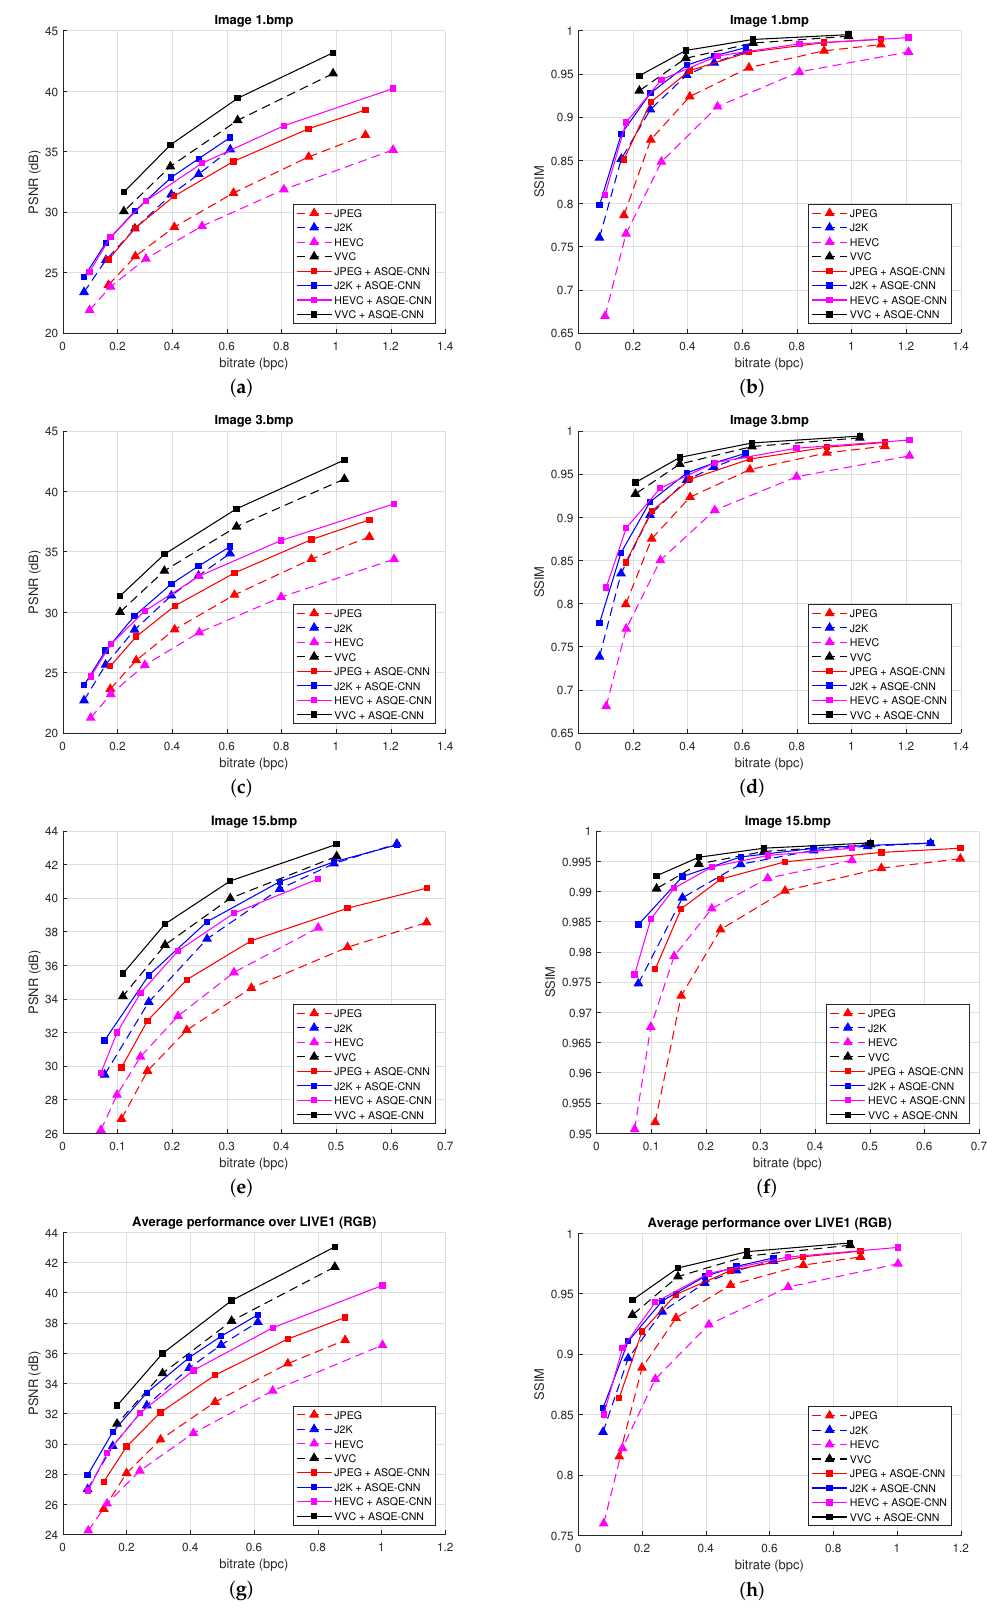
Figure 6. Rate-distortion results for three images, ( a , b ) Image 1.bmp , ( c , d ) Image 3.bmp , ( e , f ) Image 15.bmp , and over LIVE1 [54], ( g , h ). ( Left ) bpc vs. PSNR results. ( Right ) bpc vs. SSIM